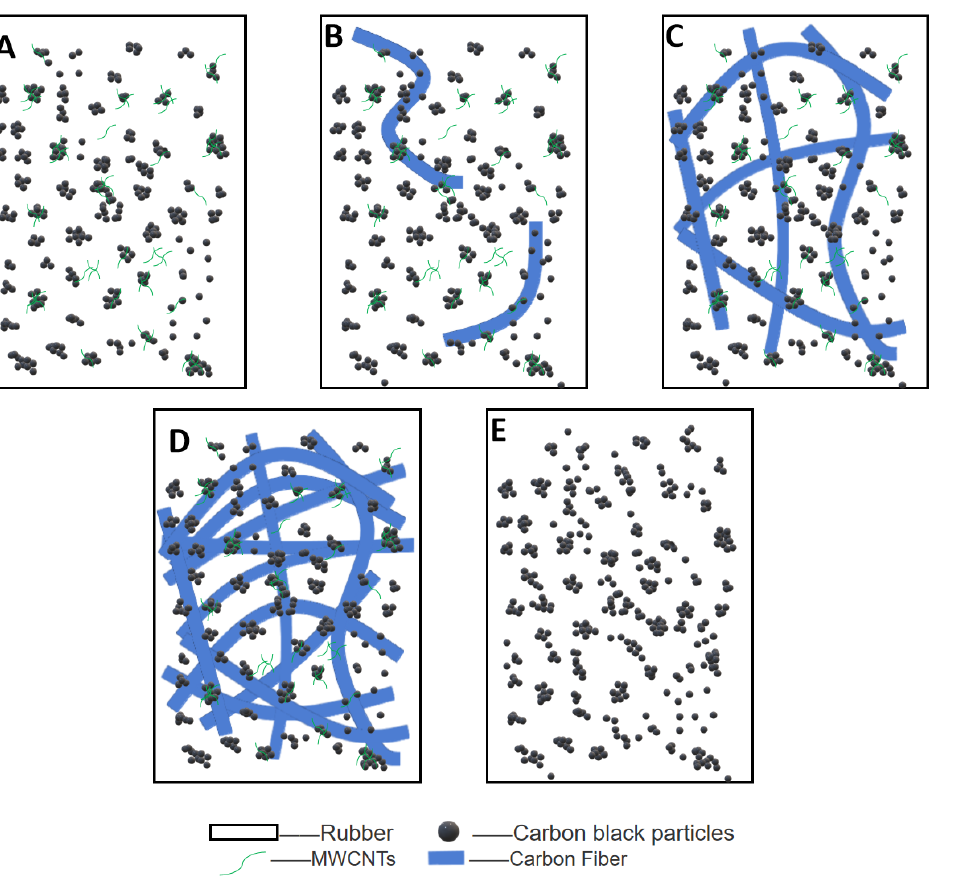
Figure 3. Form of filler in rubber. ( A ) MWCNT/CB; ( B ) A small amount of CF/MWCNT/CB; ( C ) Appropriate amount of CF/MWCNT/CB; ( D ) Excessive CF/MWCNT/CB; ( E ) MWCNT free.